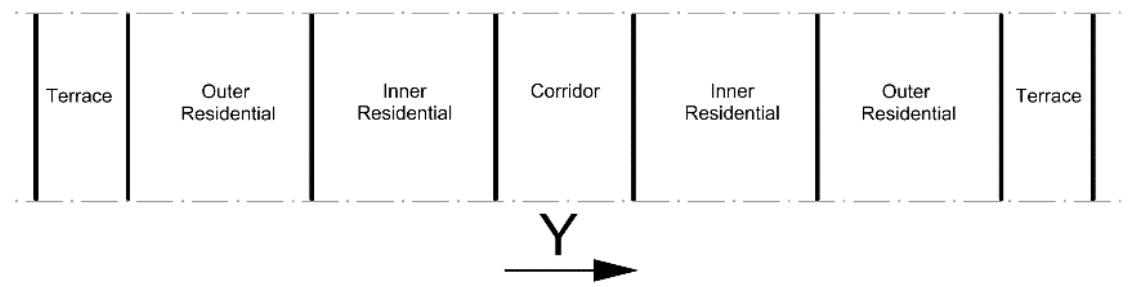
Figure 7. First subdivision across Y direction (Source: authors).